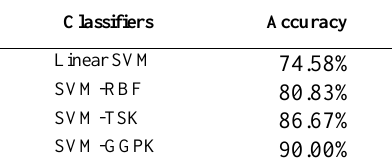
Table 3. Accuracy of linear SVM, SVM with RBF, TSK [3], and GGPK kernels on 12 different types of textures of Brodatz texture dataset.